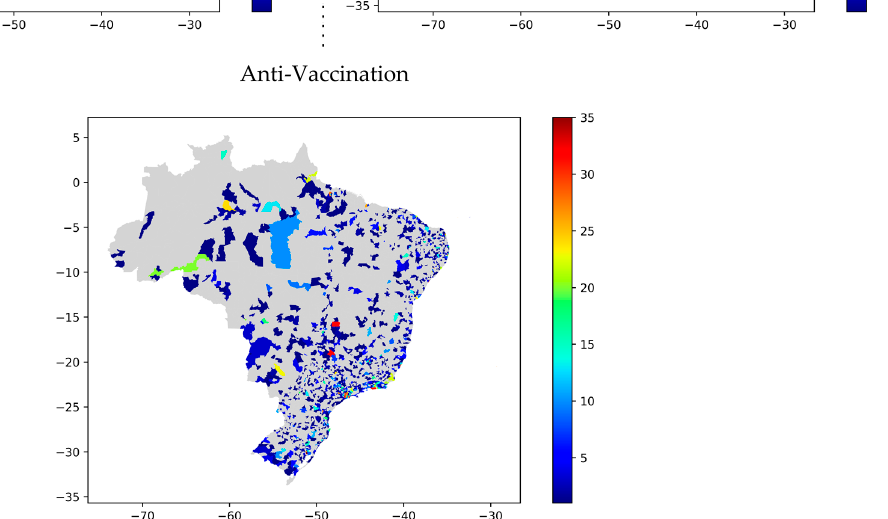
Figure 13. Distribution of tweets throughout the Brazilian territory according to polarities. It was also possible to extract the ten cities with the highest number of tweets on each map according to polarities. Table 2 details these cities, separating them according to the polarity labels and presenting the tweets counting and percentual distributions. The populations presented for the cities came from the last population census of the Brazilian Institute of Geography and Statistics, which occurred in 2010. The data in Table 2 highlights that S ã o Paulo and Rio de Janeiro (both capitals of homonymous states and the two biggest cities in terms of population) had the highest Table 2. Tweets’ counts and percentual distributions for each of the ten cities with the highest number of pro-vaccination and neutral tweets. However, compared to other cities, which number of tweets by polarity. have smaller populations, they also have the smallest distribution of the amounts according to the population size, as seen through the percentual distribution column in the table. In the anti-vaccination polarity, Porto Alegre (capital of Rio Grande do Sul) had the highest number of tweets and the third highest percentual distribution score. S ã o Paulo, followed by Rio de Janeiro, had the smallest distribution scores for the same polarity. The percentual distribution scores represent interesting information to understand the opinions’ penetration according to each city’s population size. In cities with large popula- tions, such as S ã o Paulo and Rio de Janeiro, which also had some of the highest numbers of tweets, it is noted lower percentual distributions of tweets, a fact that may indicate that the extension of opinion effects is smaller than in cities with smaller populations and large amounts of